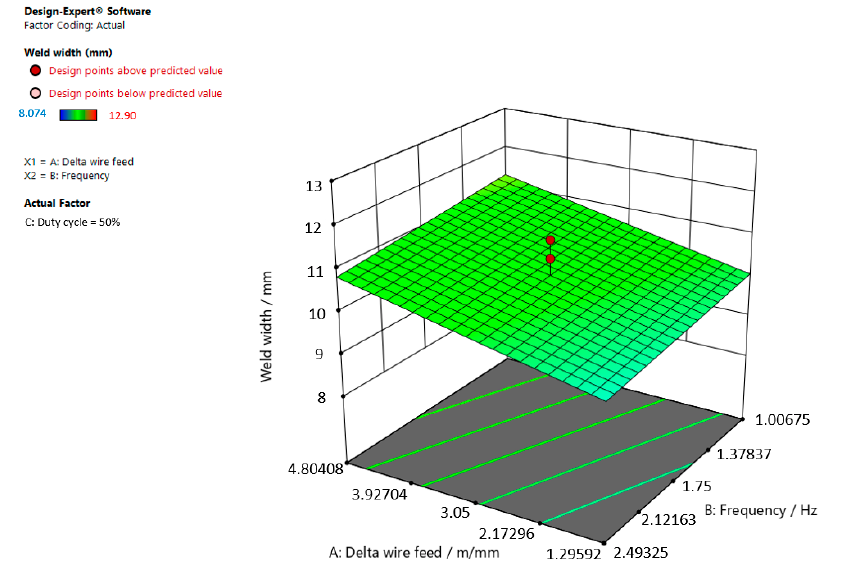
Figure 10. Response surface for the regression model of weld width at a duty cycle of 50.00%.